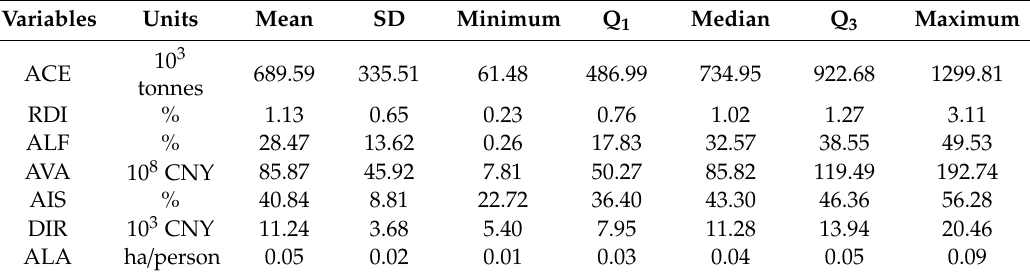
Figure 2. Spatial distribution of regression coefficients calculated by GTWR in 2008, 2012, and 2017. Table 4. The descriptive statistics of the original data of the variables used in GTWR. RDI, research and development intensity; ALF, agricultural labor force; AVA, added value of agriculture; AIS, agricultural industrial structure; DIR, disposable income of rural residents; ALA, arable land area.